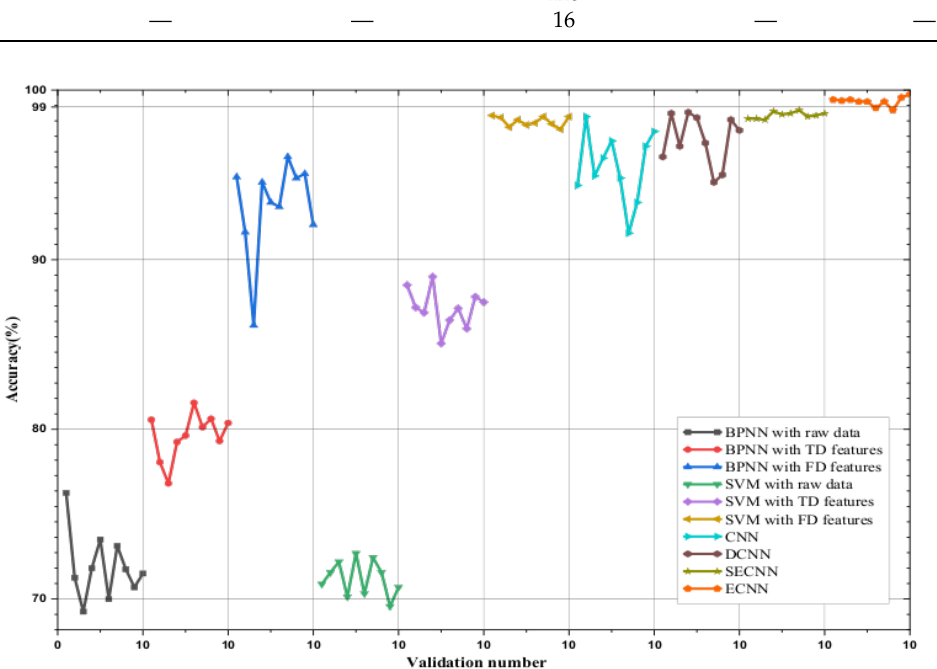
Figure 7. Diagnosis results of the ten trials using different